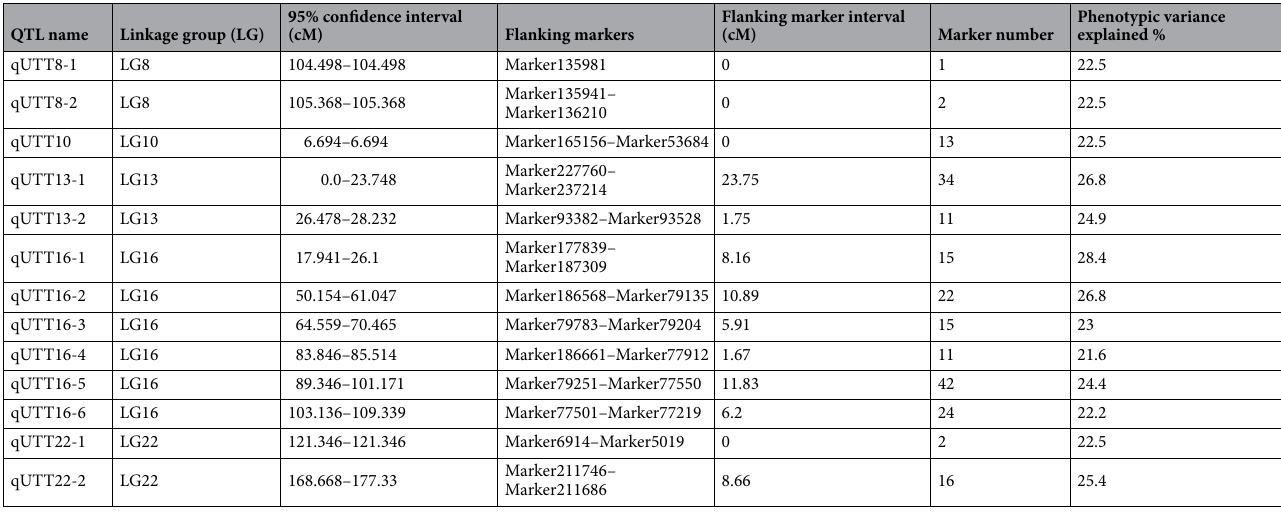
Table 4. Location of UTT QTLs in